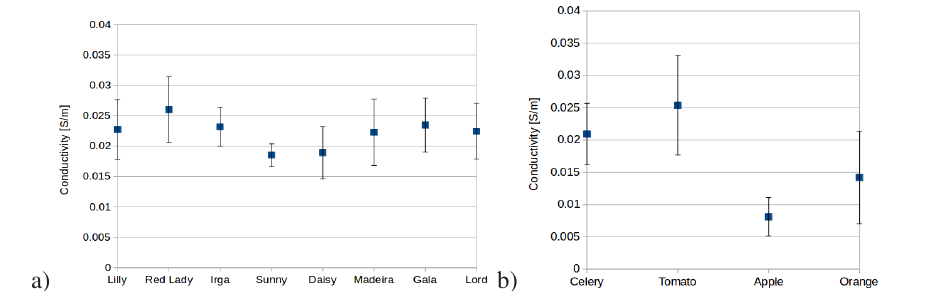
Figure 2: Conductivity measurements for 8 potato varieties (on the right) and 4 other plants Figure 1: Picture and scheme of device constructed to measure electrical conductivity of solid (left). materials with biological origin [6]